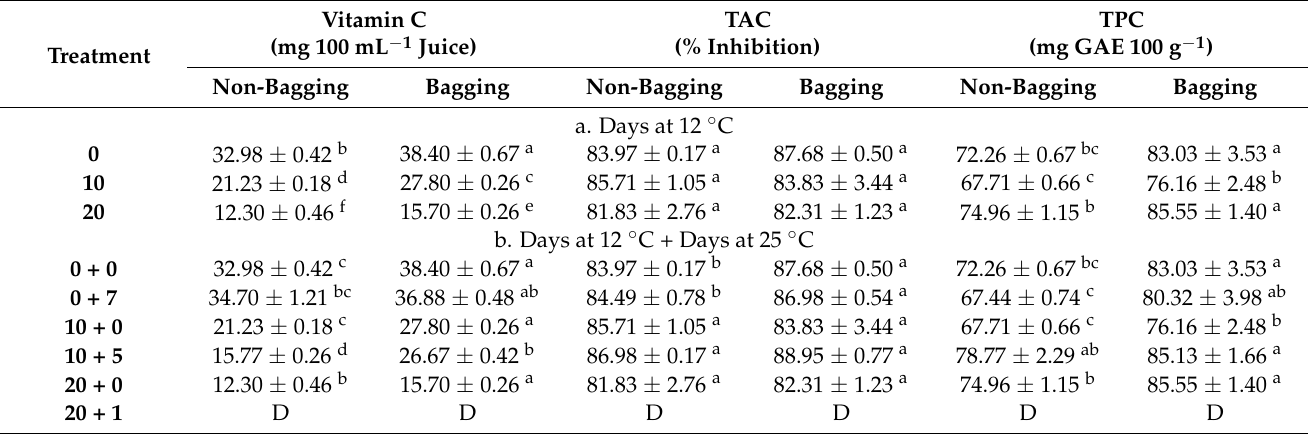
Table 3. Effect of on-tree fruit bagging treatments on vitamin C, total antioxidant activity (TAC) and total phenolic content (TPC) in mango fruits during cold storage intervals and under ambient conditions. Values are means of triplicates ± SD. Different letters in superscripts indicate significant differences according to LSD test at p ≤ 0.05. D, decayed fruits hence no tests were performed.